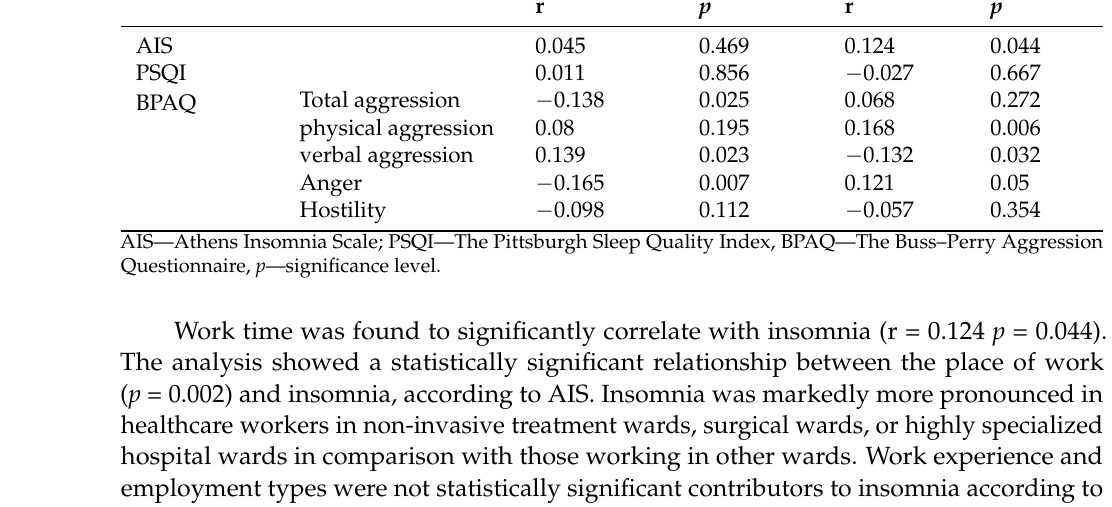
Table 6. The effect of work experience and work time on sleep disorder and aggression. Variables (Points) Work Experience Work Time r